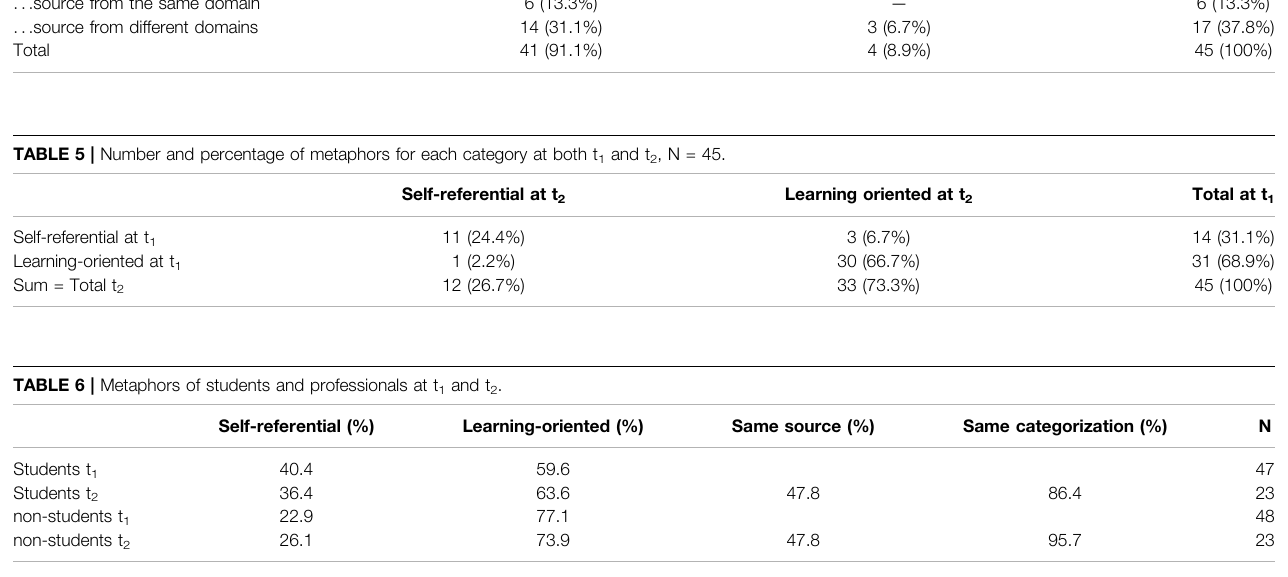
TABLE 4 | Changes of category in relation to changes in the source of the metaphor (N (cid:1) 45). The metaphor used